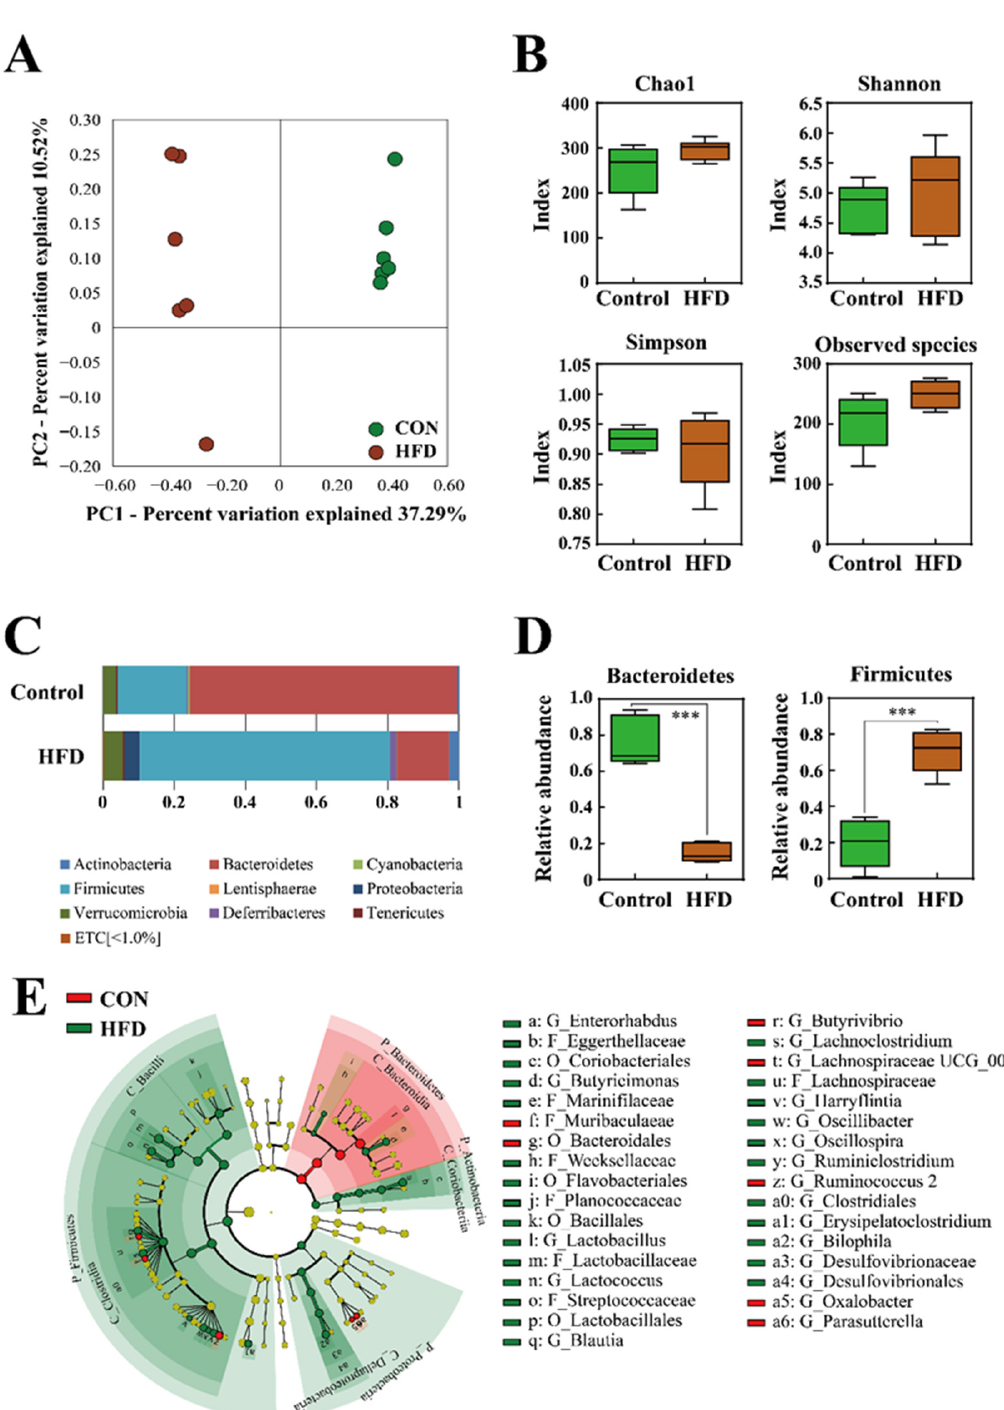
Figure 2. ( A ) Beta diversity analysis of the control and HFD groups. ( B ) Alpha diversity analysis of the control and HFD groups. ( C ) Comparison of microbiota composition at the phylum level. ( D ) Relative abundance of Bacteroidetes and Firmicutes. ( E ) Cladogram, generated using the linear discriminant analysis effect size (LEfSe) method, shows the phylogenetic distribution of microbes that are associated with the control and HFD groups. Taxonomic levels of phylum, class, and order are labelled, while family and genus are abbreviated. Plots were represented using LEfSe. Colored regions/branches indicate differences in the bacterial population structure between the control and HFD groups. Regions in green indicate clades that were enriched in the HFD group compared to those in the control group, while regions in red indicate clades that were enriched in the control group as opposed to those in the HFD group. ***, p <